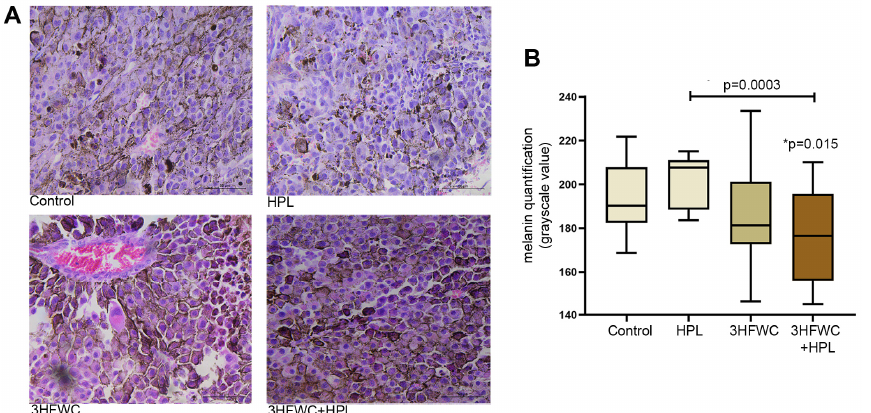
Figure 3. Alterations of melanin pigmentation in melanoma tissue in vivo induced by HPL, 3HFWC or 3HFWC+HPL treatment. ( A ) Representative HE micrographs of melanoma tissue (scale bar and orig. magnification—50 μ m, × 40); ( B ) quantification of melanin pigmentation of melanoma cells of untreated (control), HPL-, 3HFWC- and 3HFWC+HPL-treated animals; results presented as min to max values, with median; statistical significance in comparison to control (* p value) and between the treated groups.